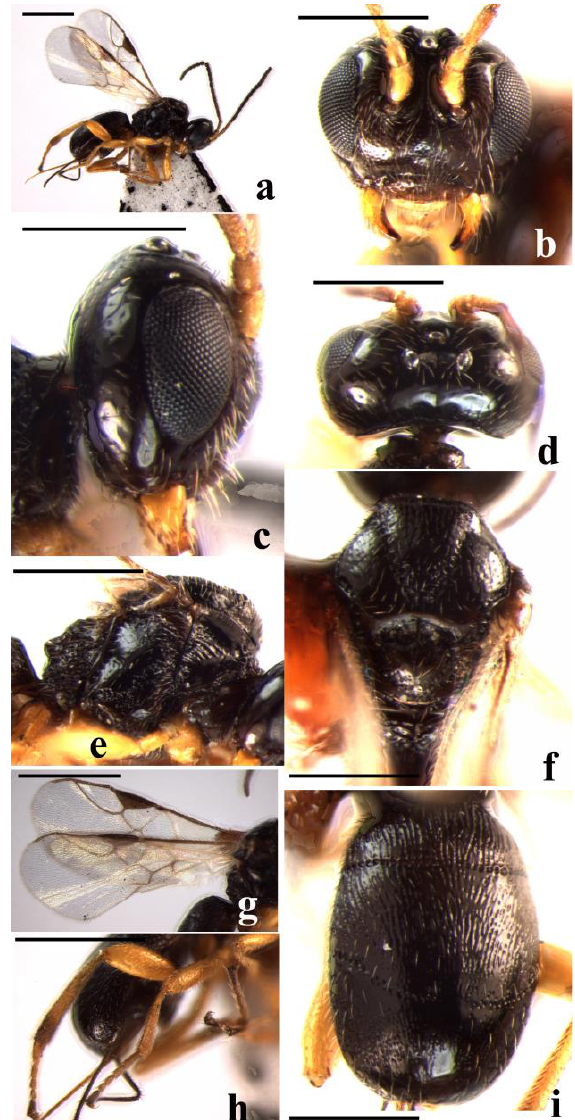
Figure 6. Schizoprymnus septentrionalis sp. nov., holotype, ♀ . ( a ) Habitus, lateral aspect; ( b ) head, frontal aspect; ( c ) head, lateral aspect; ( d ) head, dorsal aspect; ( e ) mesosoma, lateral aspect; ( f ) mesoscutum, dorsal aspect; ( g ) fore wing; ( h ) hind leg, lateral aspect; ( i ) carapace, dorsal aspect. Scale bar: 1 mm.